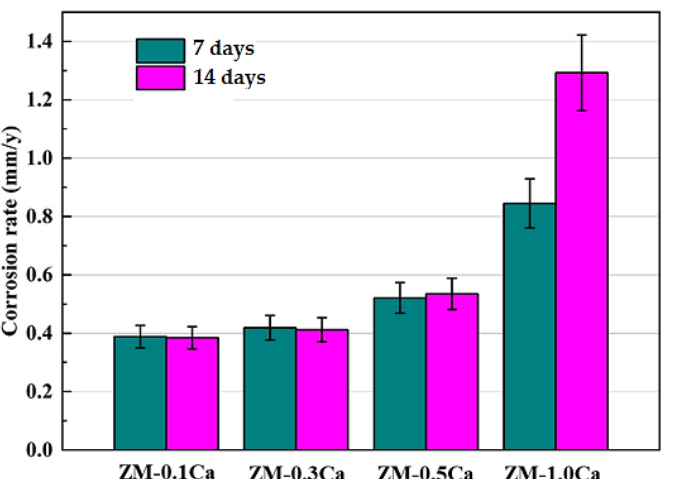
Figure 6. Corrosion rates of the ZM-xCa alloys obtained by weight loss after immersion in Hank’s solution for different times.